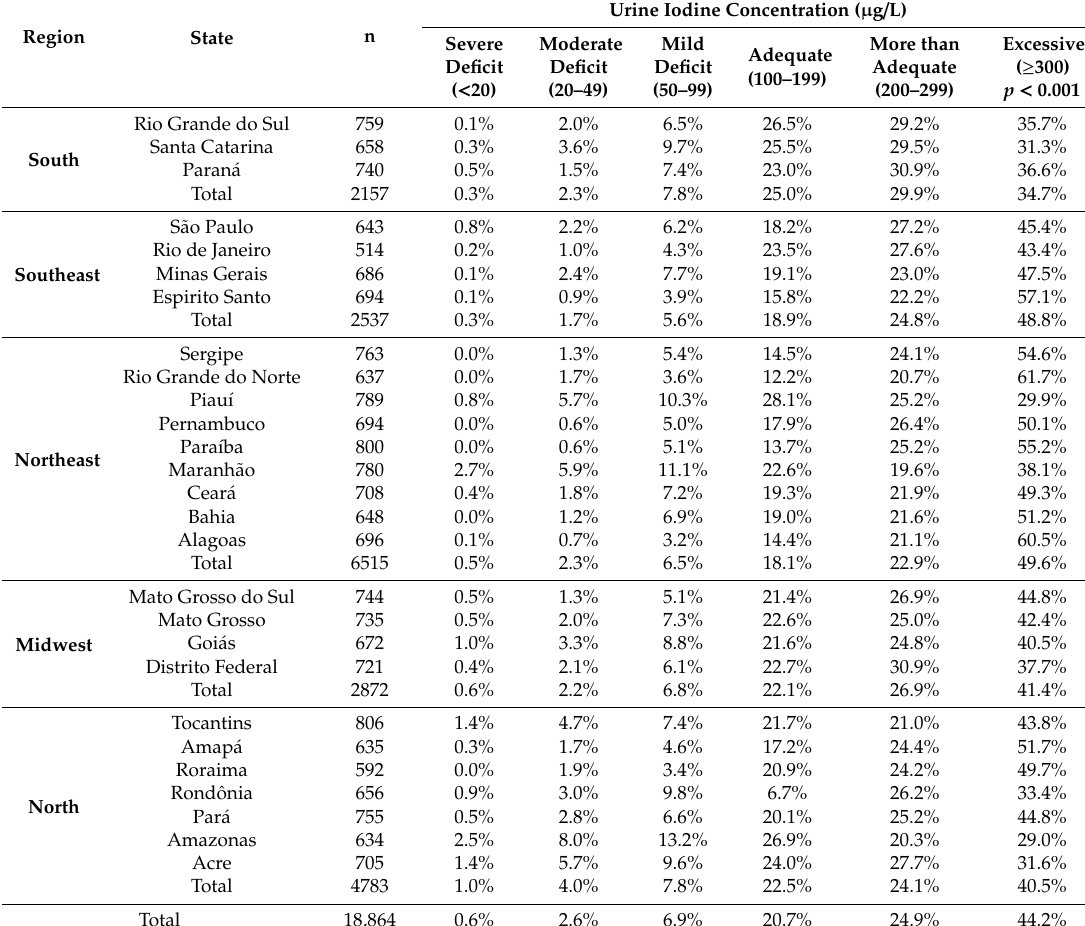
Table 4. Iodine concentration in µ g / L by region and State, Brazil, 2008–2014.